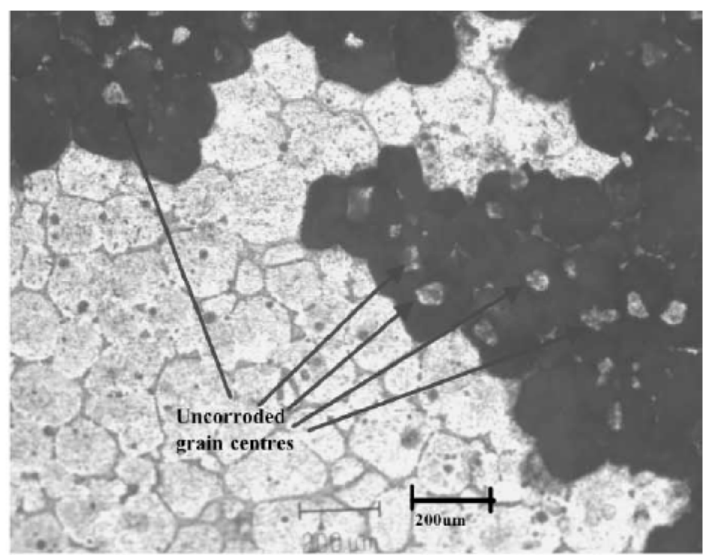
Figure 28. Optical micrographs of MEZ R surface after immersion in chloride solution for 3 h. Reproduced with permission from [151], Elsevier, 2002.